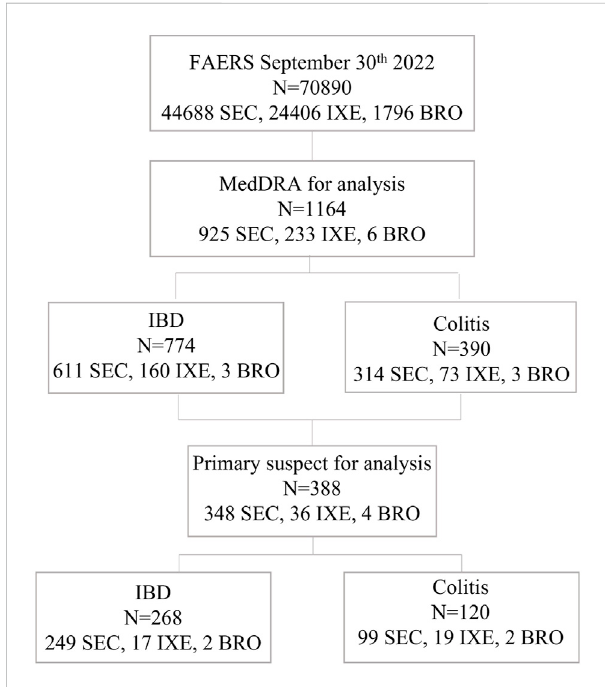
FIGURE 1 Flow chart of the study protocol. FAERS, FDA Adverse Event Reporting System; MedDRA, Medical Dictionary for Regulatory Activities Terminology; IBD, in fl ammatory bowel diseases; SEC, secukinumab, IXE, ixekizumab IXE; BRO,